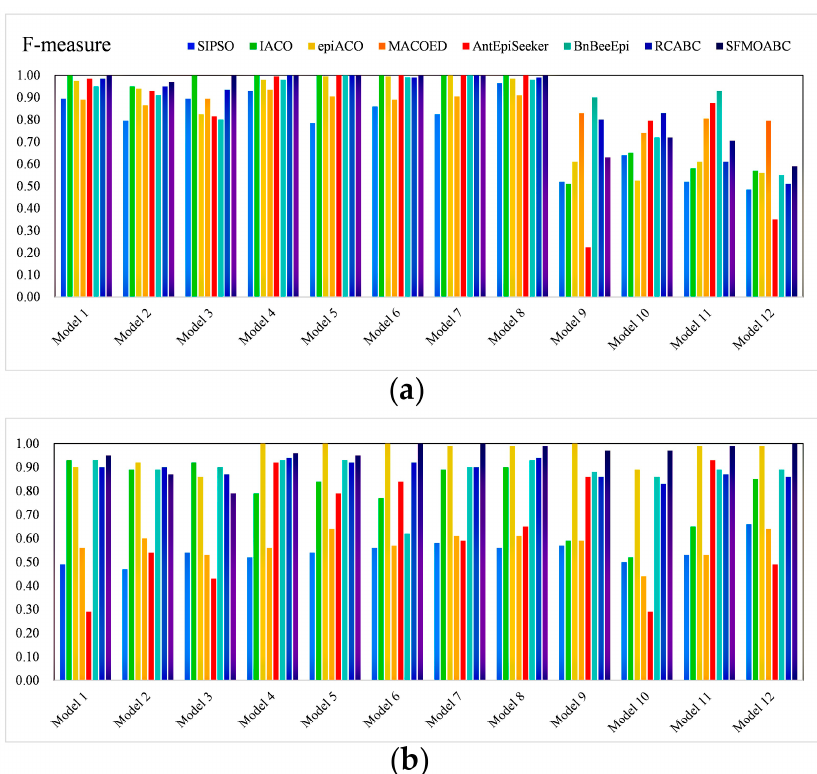
Figure 5. F-measure of methods based on the swarm intelligence algorithm: ( a ) F-measure on the small-scale datasets; ( b ) F-measure on the large-scale datasets.